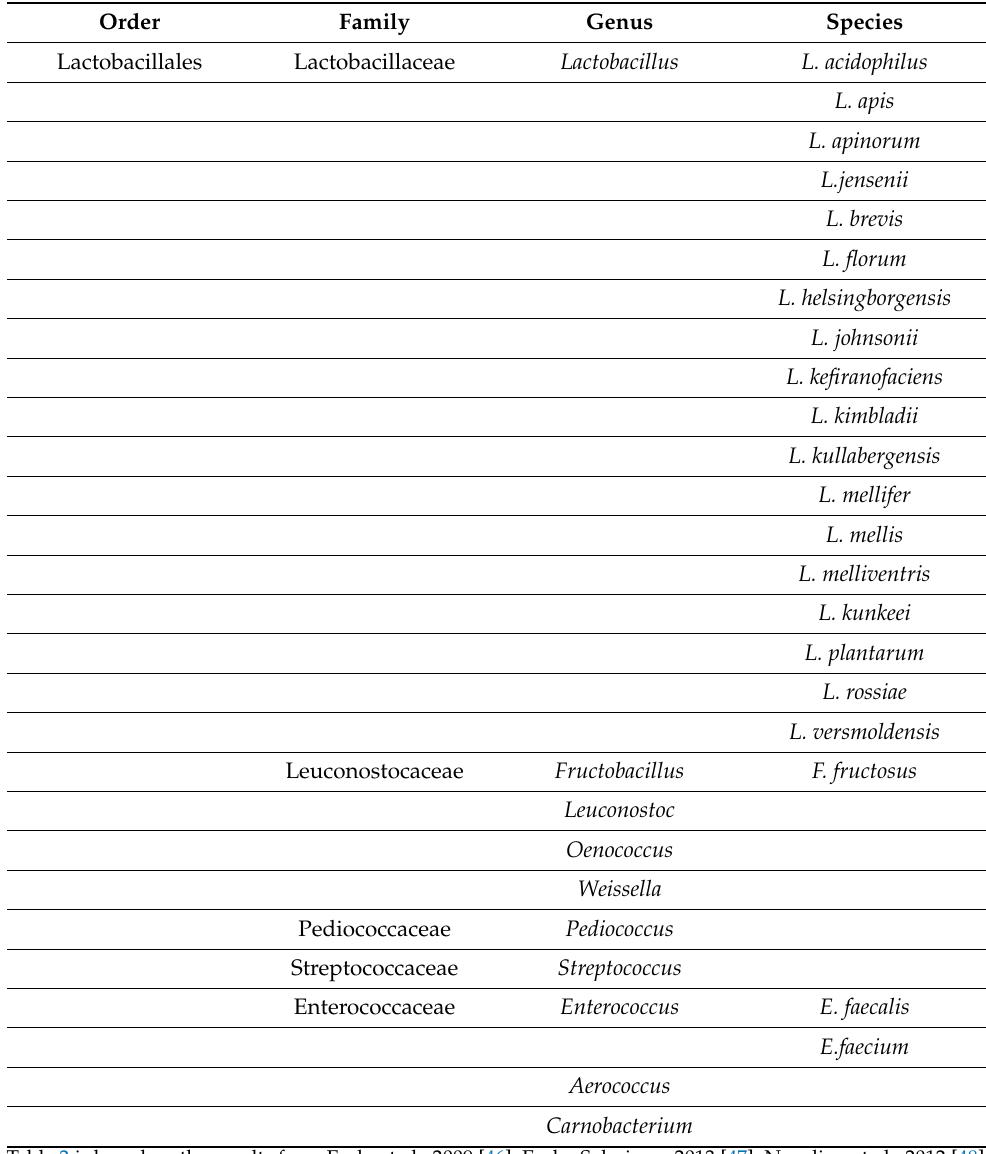
Table 2 is based on the results from Endo et al., 2009 [46], Endo, Salminen, 2013 [47], Neveling et al., 2012 [48], Olofsson, V á squez, 2008 [49] and Olofsson et al., 2014